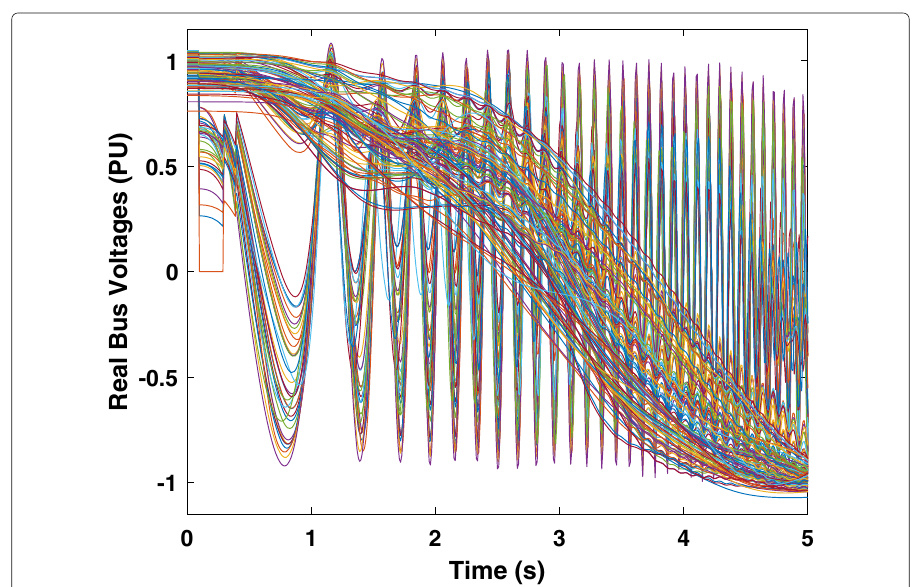
Fig. 3 Coherent Swing Instability. CSI in numerical simulations: Plotting bus voltages shows two qualitatively different types of dynamics. Each bus belongs to one of two coherent groups, one of which varies at a slow, consistent time scale and the other of which oscillates with linearly increasing frequency